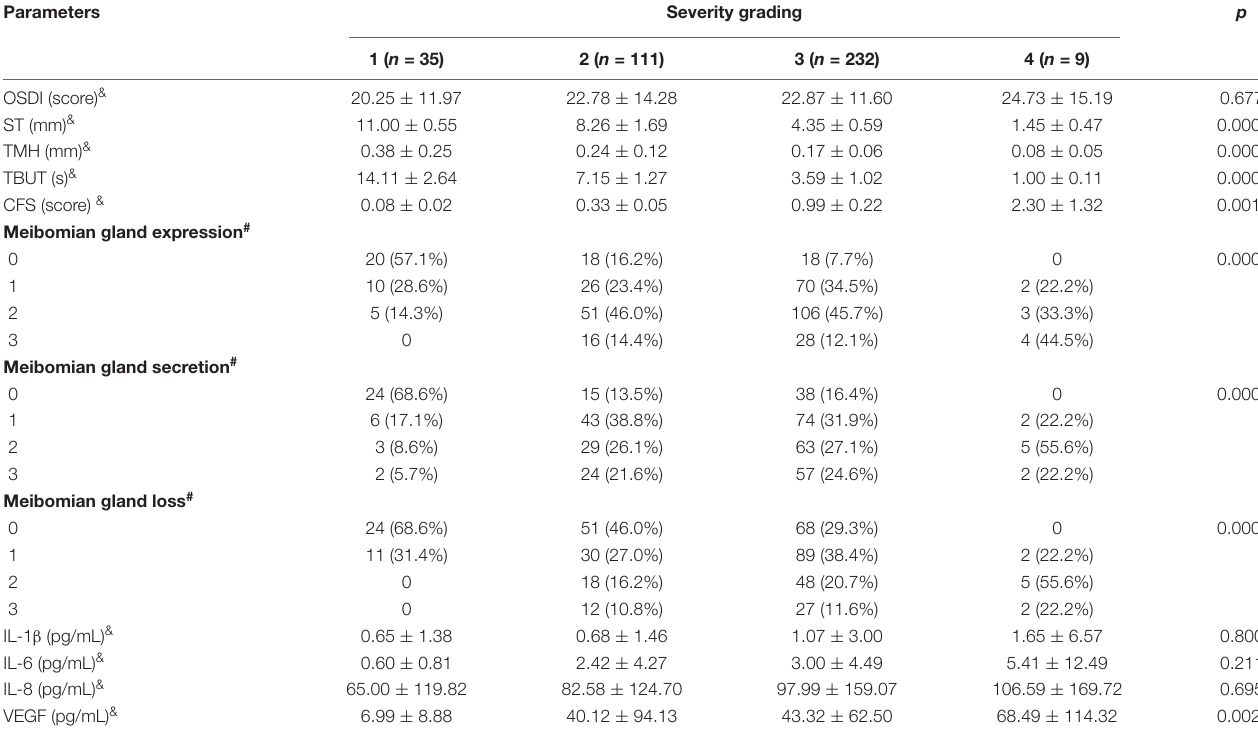
TABLE 2 | Clinical characteristics and tear cytokines in patients with different severity grades. Parameters Severity